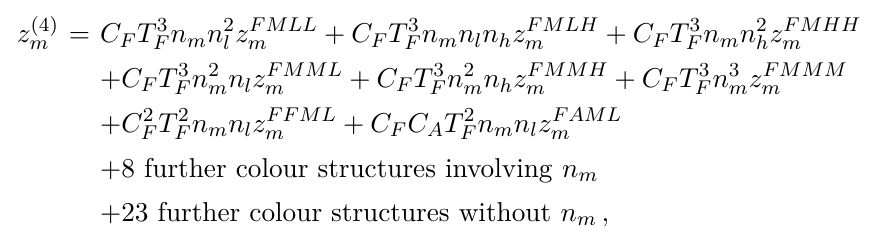
Figure 1 . Sample Feynman diagrams contributing to Z OS quarks and gluons, respectively. Dashed and double lines represent massless fermions and fermions with mass m 2 ,